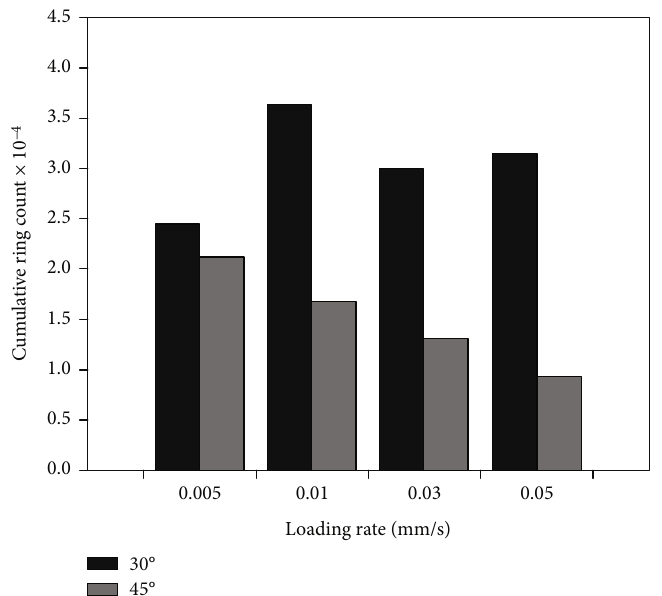
Figure 14: Comparison of cumulative ring counts of specimens with the crack inclination angles of 30 ° and 45 ° under di ff erent loading conditions.